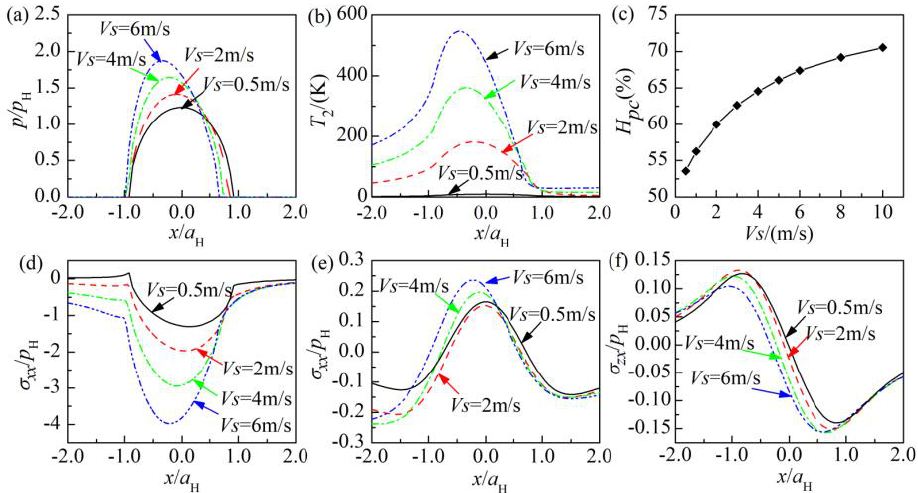
Figure 7. Effect of the sliding speed V s on: ( a ) contact pressure along x axis, ( b ) surface temperature rise along x axis, ( c ) frictional heat partition coefficient, ( d ) σ xx on the surface, ( e ) σ xx at the base of the coating, ( f ) σ zx on the interface.